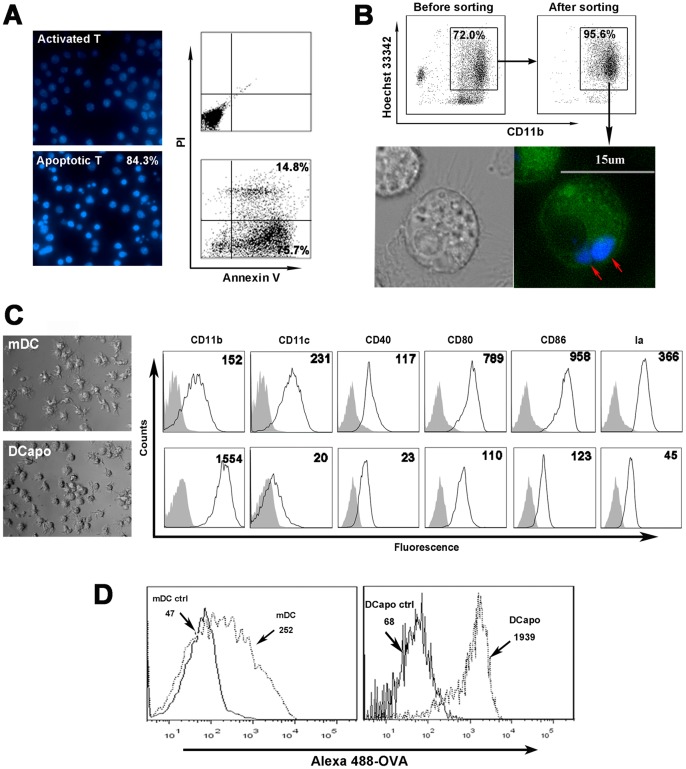
Morphology, phenotype, and endocytic ability of mDCs and DCapos. (A) Apoptosis of CD4+ T cells. Left panel, top left (×400): CD4+ T cells stained by Hoechst 33342 after activation by mDCs and OVA323–339 for 2 days; bottom left (×400): after activation by mDCs and OVA323–339 for 5 days, CD4+ T cells were cultured for another 2 days in the absence of mDCs and then stained by Hoechst 33342. Numbers showed the percentage of apoptotic cells in high power field. Upper right panel, control cells. Lower right panel, apoptotic CD4+ T cells were assessed by flow cytometry with Annexin V and PI. (B) Purification of DCapos. Top panel, DCs were co-cultured with apoptotic CD4+ T cells prelabeled with Hoechst 33342. Then the CD11b+Hoechst+ cells were sorted by flow cytometry. Numbers showed the purity of the sorted cells. Bottom panel, DCs incubated with apoptotic CD4+ T cells prelabeled with Hoechst 33342 (blue with red arrows) and incubated for 2 hours. The DCs were then stained with CD11b-FITC (green) and observed under a light microscope (left) and a confocal immunofluorescence microscope (right). Bar represent 15 µm. (C) Morphologies and phenotypes of mDCs and DCapos. Left panel, left top (×400), the morphology of mDCs; left bottom (×400), the morphology of DCapos. Right panel, different groups of DCs were stained with fluorescence-conjugated anti-CD11b, anti-CD11c, anti-CD80, anti-CD86, anti-CD40, and anti-Ia mAbs for flow cytometric analysis. Numbers represented the mean fluorescence intensity. (D) Endocytic abilities of mDCs and DCapos were assessed by flow cytometry of Alexa 488-OVA uptake. Numbers in the histograms indicate the geometric mean fluorescence of each DC population. Ctrl, control (cells incubated with Alexa 488-OVA at 4°C). Data represent results of 1 of the 3 experiments performed to yield similar results.